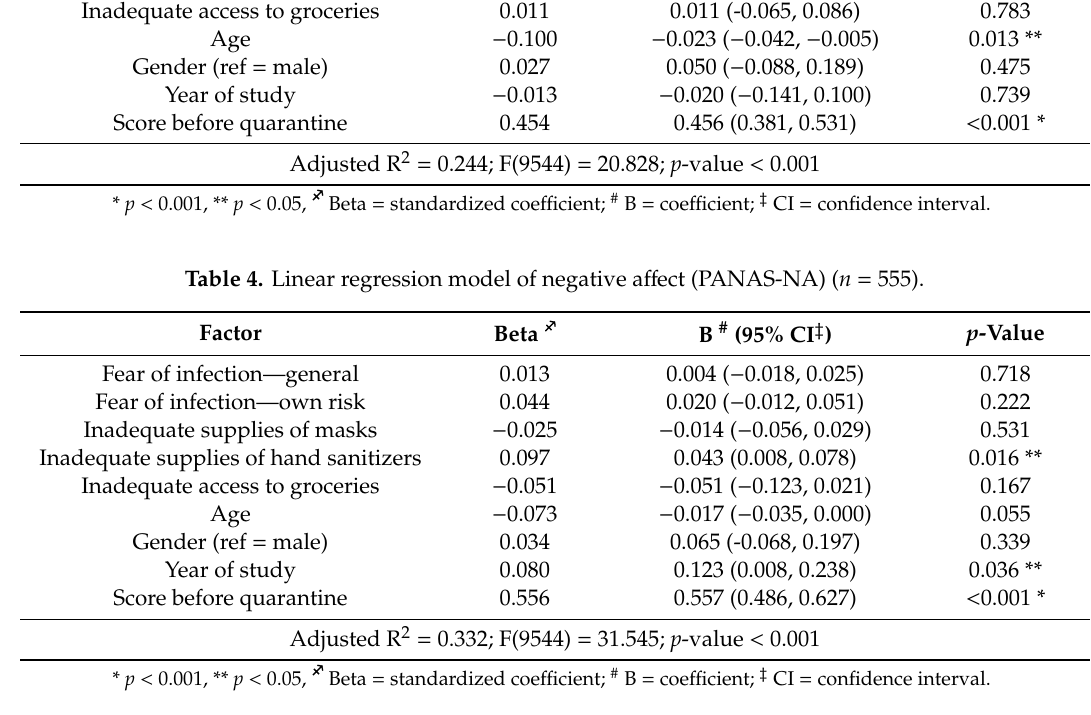
Table 5. Linear regression model of anxiety and depression (PHQ-4) ( n = 555). Factor